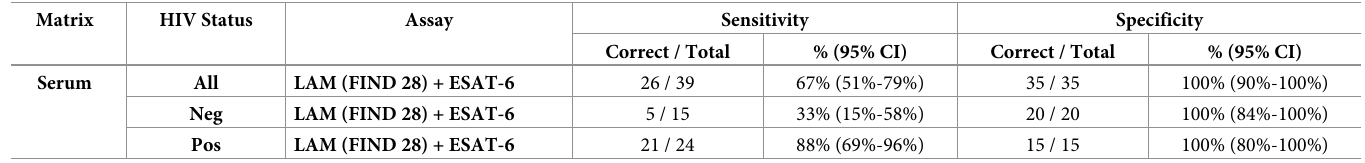
Table 3. Accuracy of combining ESAT-6 result and LAM result. A sample was characterized as positive if either the LAM or ESAT-6 assays gave signals above their respective thresholds. Sensitivity, specificity and confidence limits were determined as described in the Table 2 legend. Matrix HIV Status Assay Sensitivity Specificity Serum